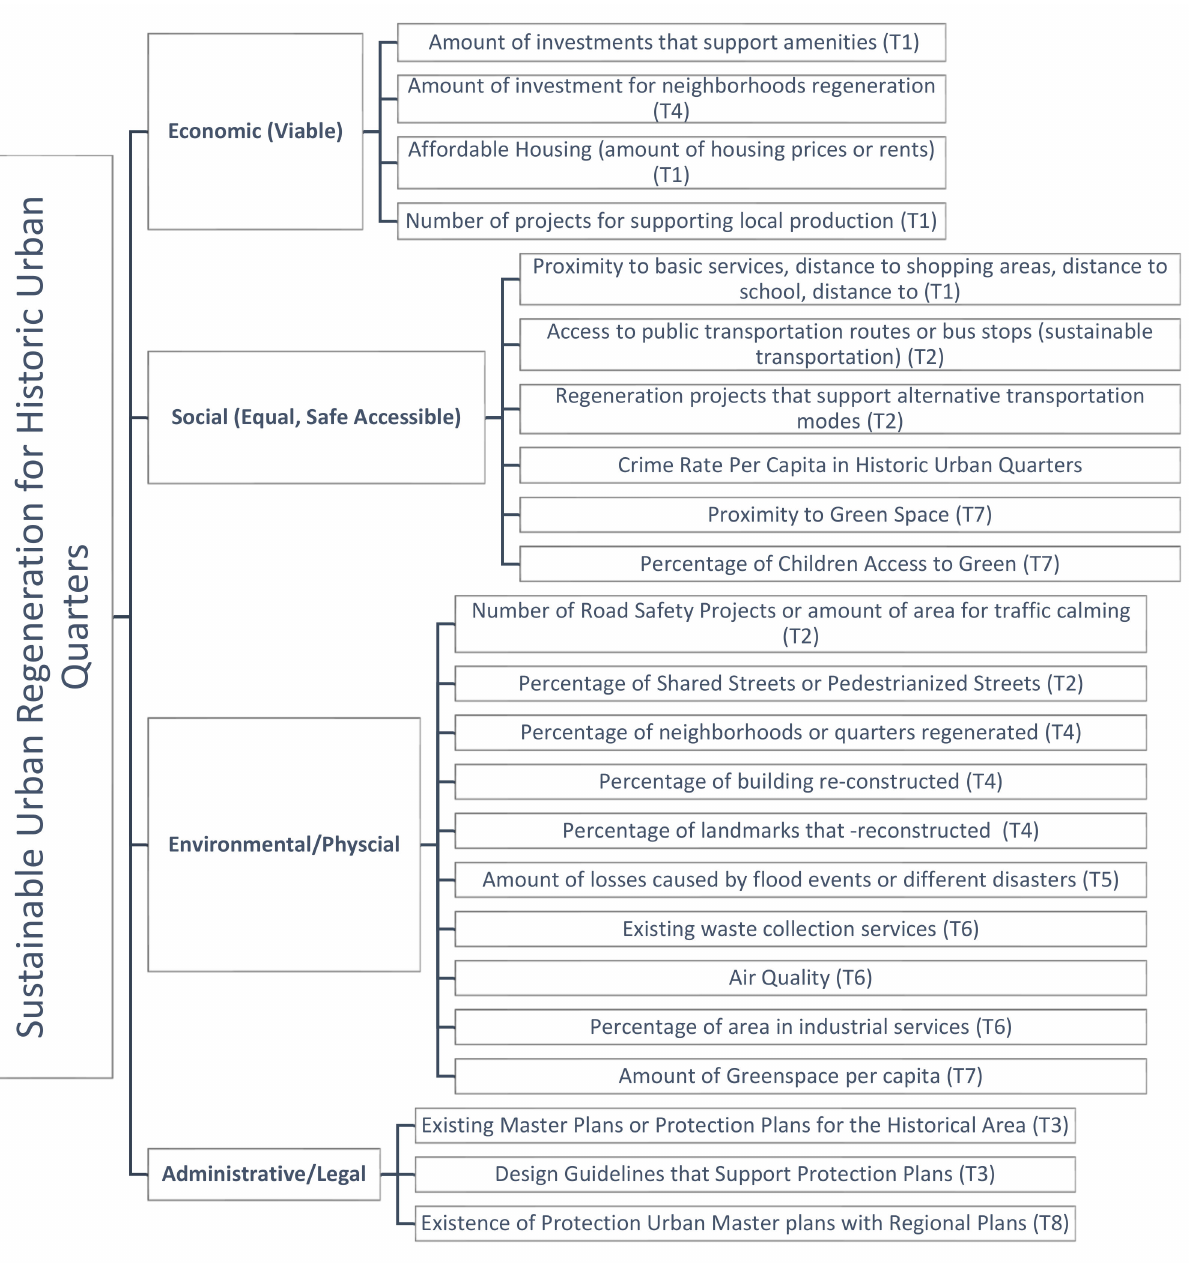
Figure 4. Hierarchy for Sustainable Urban Regeneration for Historic Urban